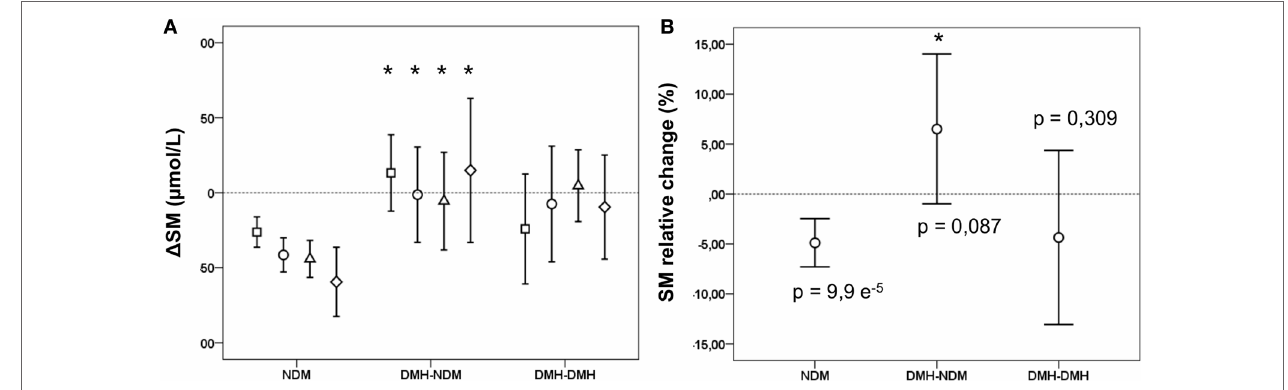
FigUre 2 | Changes in sphingomyelin (SM) concentration after Roux-en-y gastric bypass (RYGB) surgery in non-diabetic and diabetic subgroups. Figures show mean and a 95% confidence interval of the mean for differences ( Δ SM) between SM concentrations before surgery and at 3 (squares), 6 (circles), 12 (triangles), and 24 months (diamonds) after RYGB, respectively (a) ; and the relative change in SM at 3 months after surgery in percent (B) . NDM, patients without diabetes mellitus (DM); DMH-NDM, patients with DM in remission after RYGB; DMH-DMH, patients with DM not in remission after RYGB. Shown p -values are from a one-sample t -test, comparing the change with 0. Significantly different values when compared to corresponding value in the NDM subgroup is marked with a * ( p <